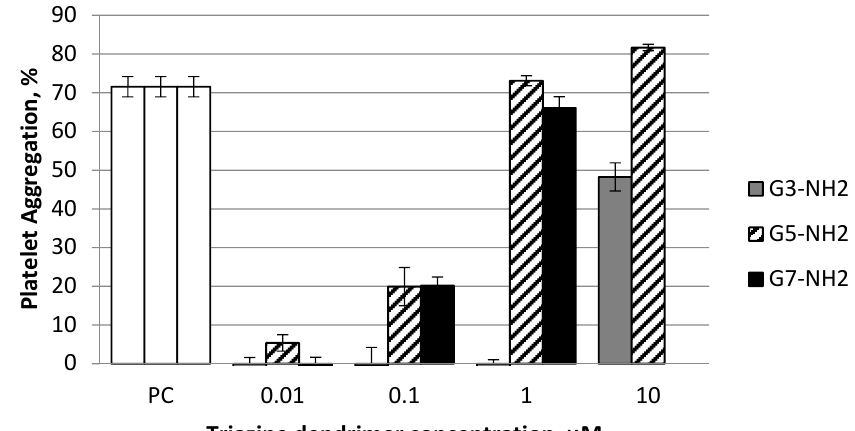
Figure 1. Induction of platelet aggregation by amine terminated triazine dendrimers is size-dependent. Different concentrations of generations 3, 5, and 7 of triazine dendrimers with amine terminal groups that were incubated with human platelet reach plasma for 15 min at 37 °C. After that, platelet count was performed using a Z2 cell and particle counter. Platelet count in the test samples was compared to that in the negative control sample to calculate percent platelet aggregation. Collagen was used as an assay positive control (PC). Shown is mean ± SD ( n = 3).